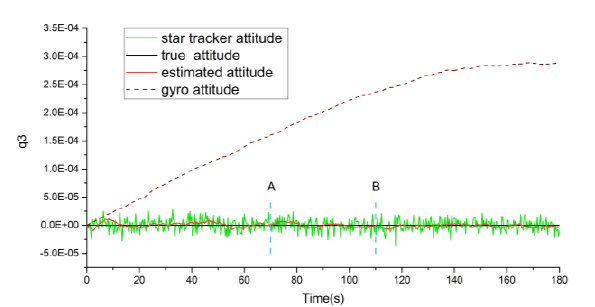
Figure 3. The accuracy comparison of quaternion q3 by different attitude estimation methods.